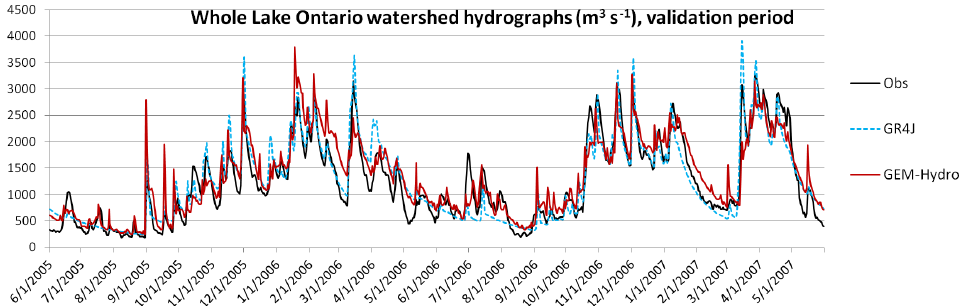
Figure 8. Lake Ontario basin runoff (including its ungauged areas, Fig. 2) for the validation period, comparing GR4J and GEM-Hydro.